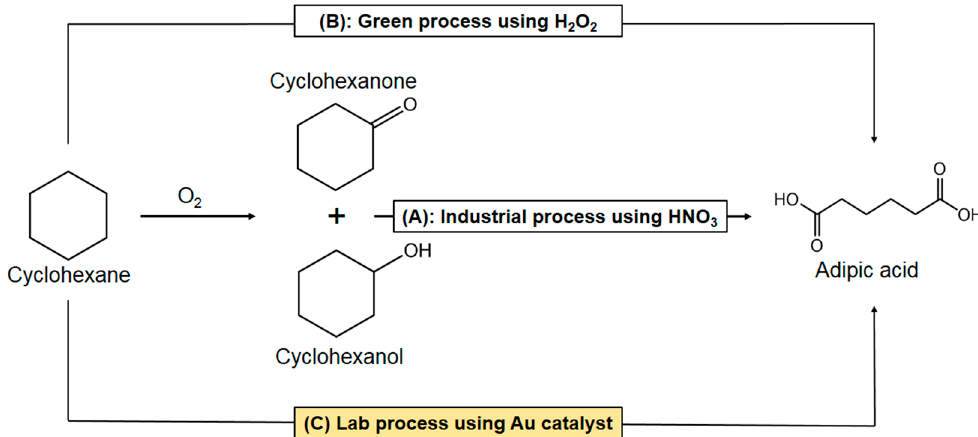
Figure 6. Chemical methods of adipic acid production from cyclohexane. ( A ) industrial process using HNO 3 , ( B ) conversion of cyclohexane to adipic acid by using H 2 O 2 , ( C ) green route process using supported AuNPs catalyst.